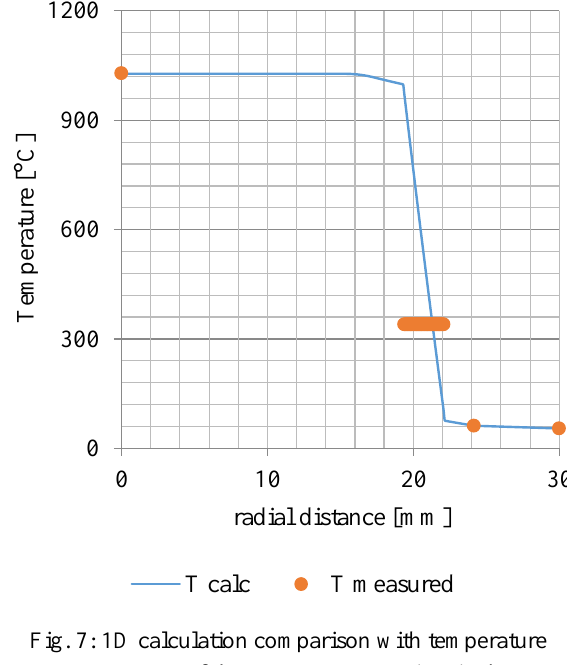
Fig. 7: 1D calculation comparison with temperature measurements. One of the measurement points in the gas gap not well defined.